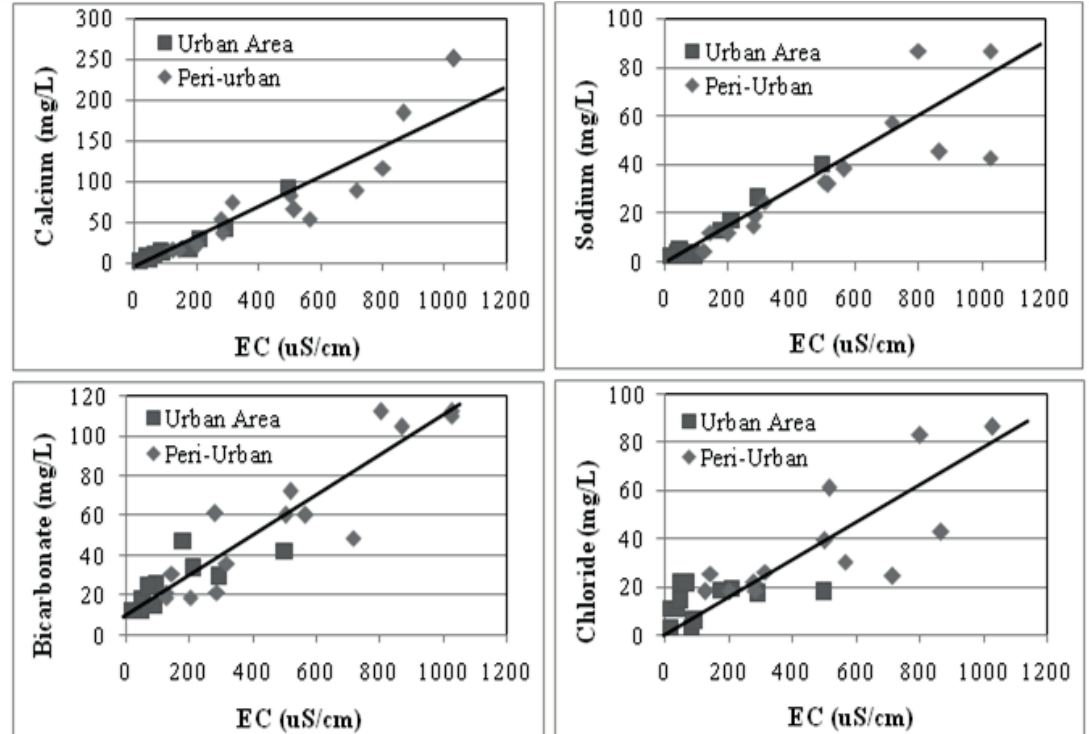
Fig. 2 Cross plots of the major ions against electrical conductivity